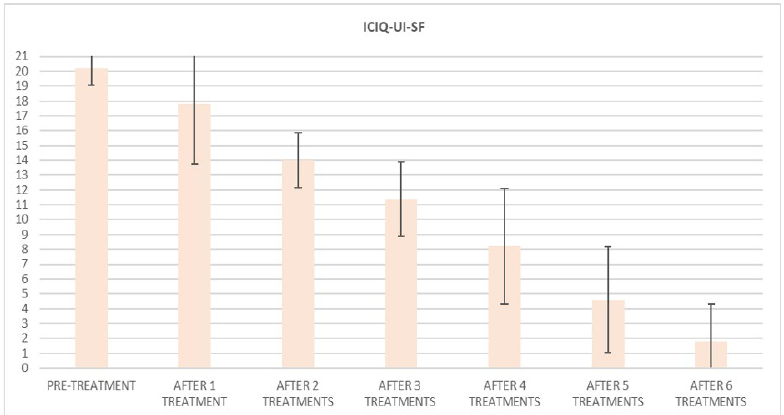
Figure 2. Histogram representation of results from ICIQ-UI-SF at baseline and at each treatment session until the 6th treatment session.